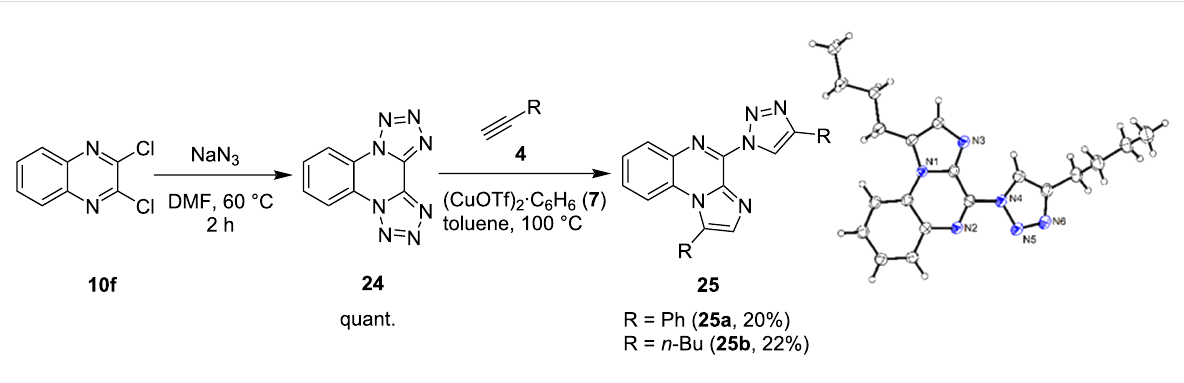
Scheme 5: Synthesis of bis(tetrazolo)[1,5- a :5',1'- c ]quinoxaline ( 24) and conversion to triazoloimidazoquinoxalines (TIQs): 2.5 equiv hexyne, 10 mol % (CuOTf)